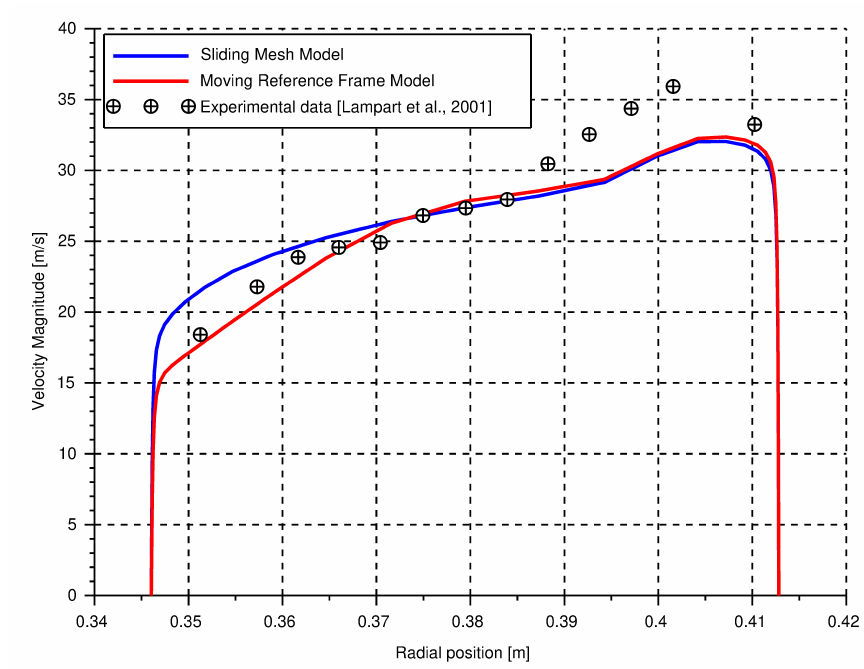
Figure 9. Comparison of computed and experimental radial distribution of absolute speed at 135% of the axial chord downstream of the rotor trailing